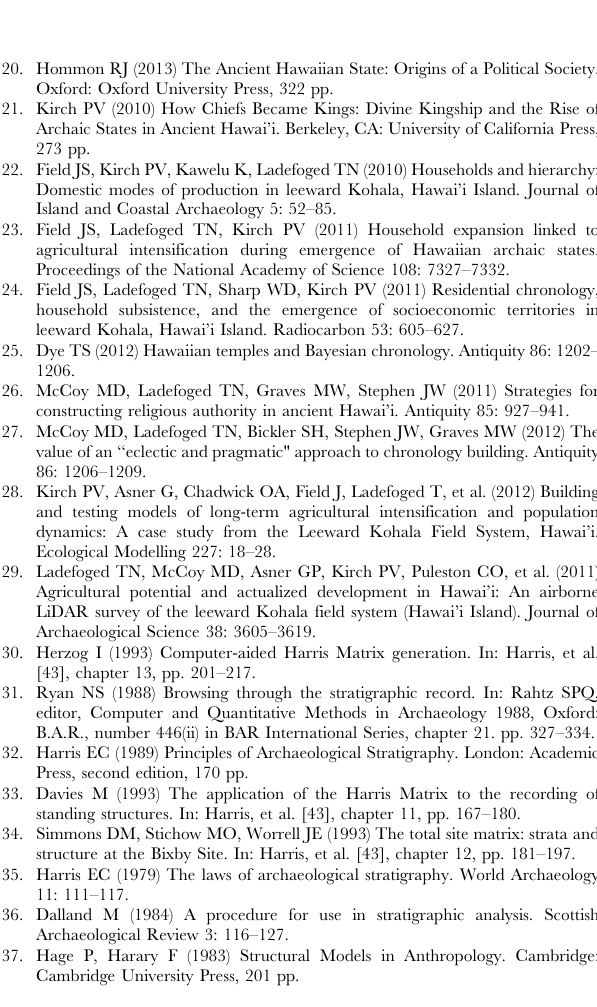
Figure S3 Directed graph of the agricultural walls and trails in the Kahua 1 and Pa¯hinahina detailed study